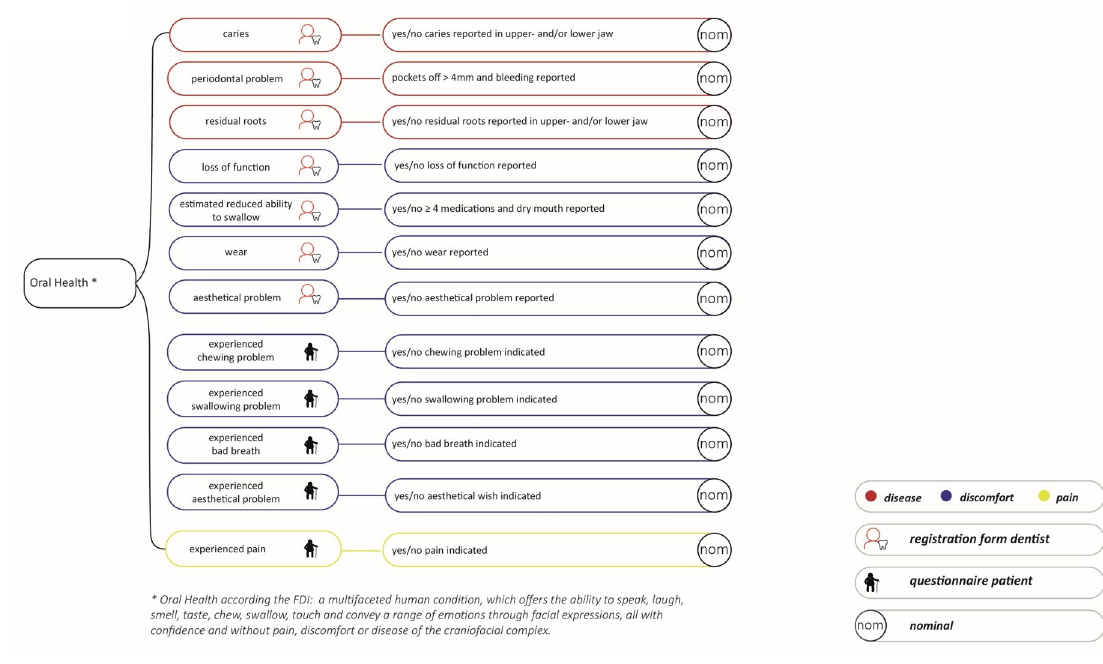
Fig 2. Aspects oral